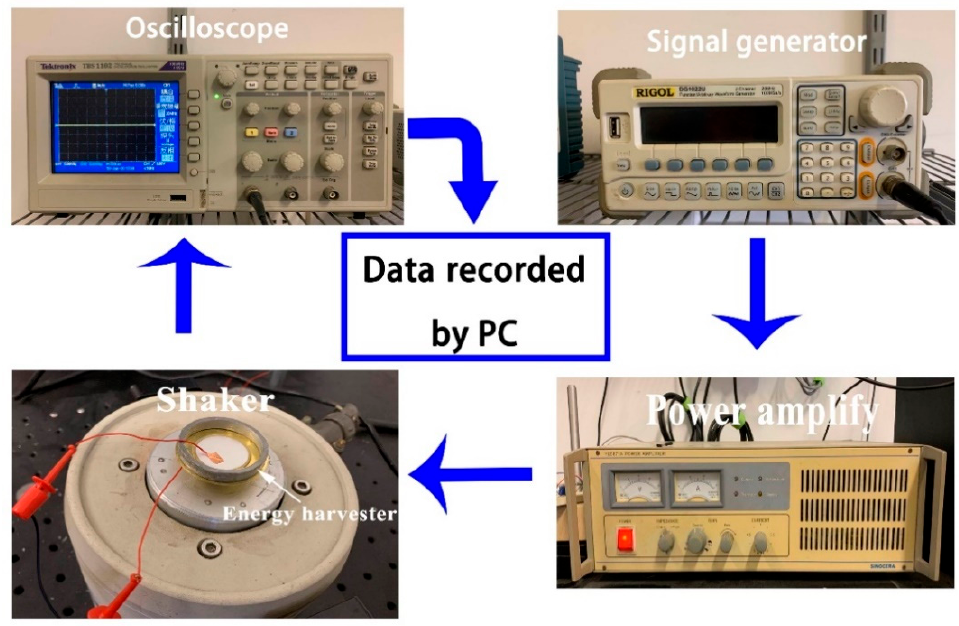
Figure 1. Schematic diagram of the piezoelectric energy harvesting test platform.